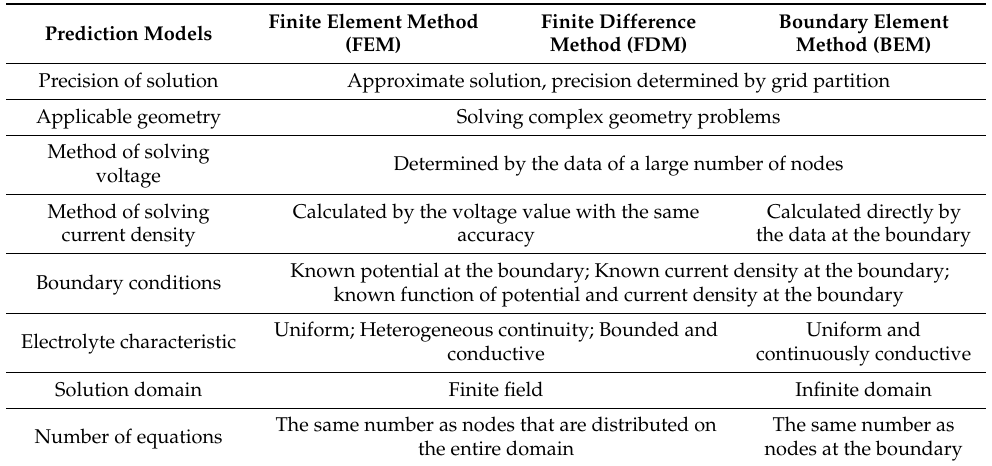
Table 3. Comparison of numerical analysis methods